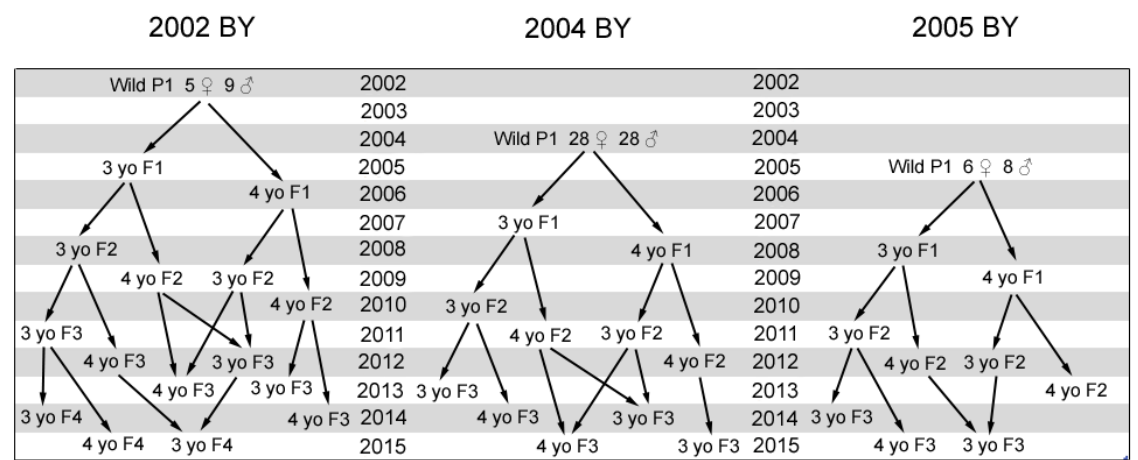
Figure 2. Pedigree showing Sakinaw sockeye salmon parental (P ) fish spawned at Ouillet 1 –F ) groups spawned in the captive breeding program at Rosewall hatchery and filial (F 1 4 hatchery. Fish matured at ages three (3 yo) and four (4 yo). Fish were reared in pooled groups at Rosewall hatchery from each broodyear (BY) so that individual identity was not maintained. Spawning was among available fish from all three parental lineages each year although only crosses within lineages are